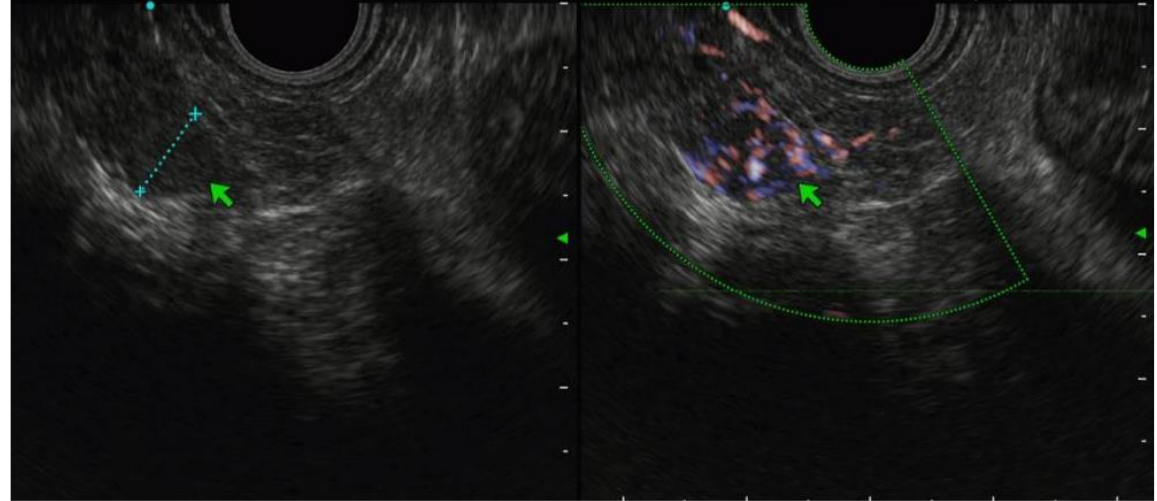
Figure 3. Renal cancer metastasis to pancreas. Green arrows point at margins’ irregularity.